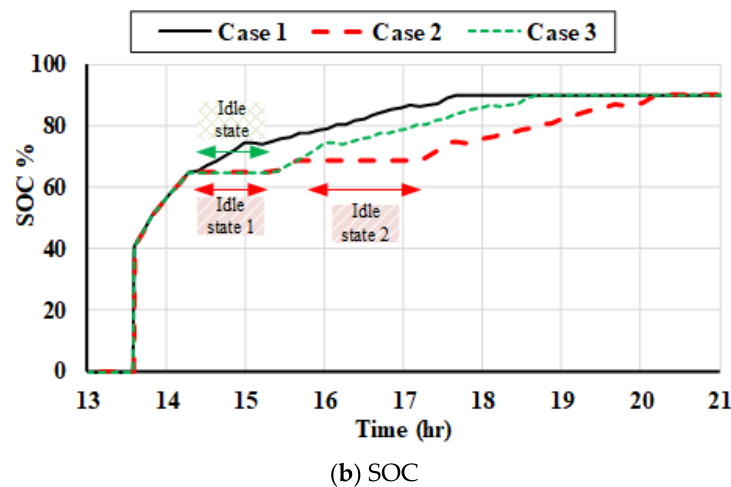
Figure 18. EV# j charging behavior at different case studies.